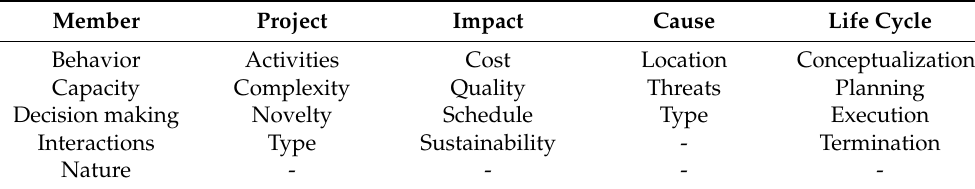
Table 2. The second level of faceted hierarchy for uncertainty sources in a construction project, where the primary node is “Uncertainty sources in a construction project”. Member Project Impact Cause Behavior Activities Cost Location Capacity Complexity Quality Threats Planning Decision making